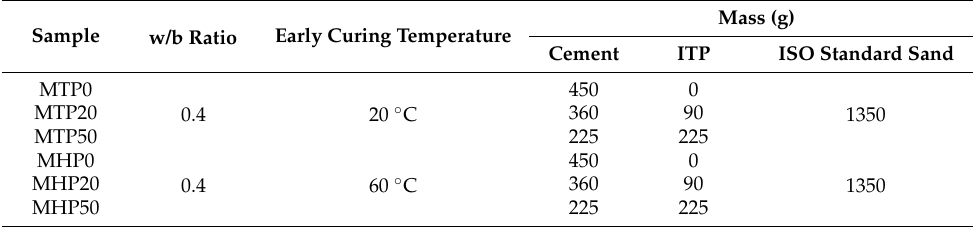
Table 3. Mix proportions of